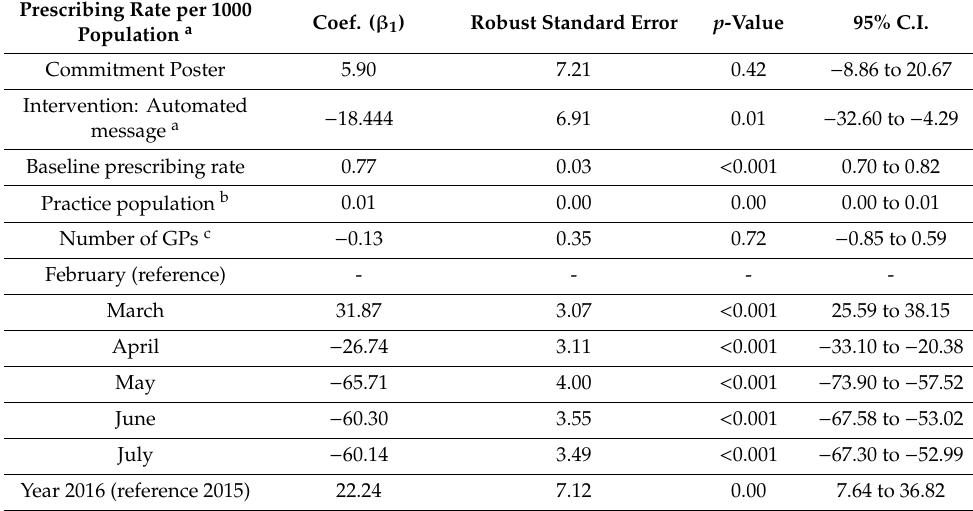
Table 3. Regression estimates for the e ff ect of the pooled